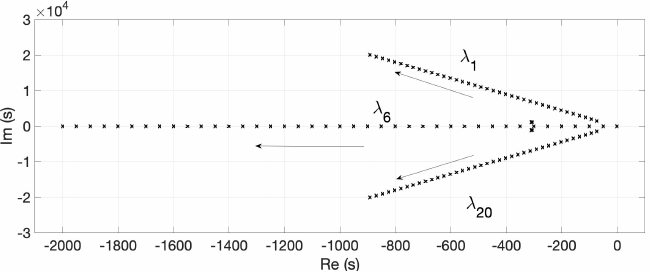
Figure 20. Loci of the closed-loop system poles for the range of ω FL , PLL = 50